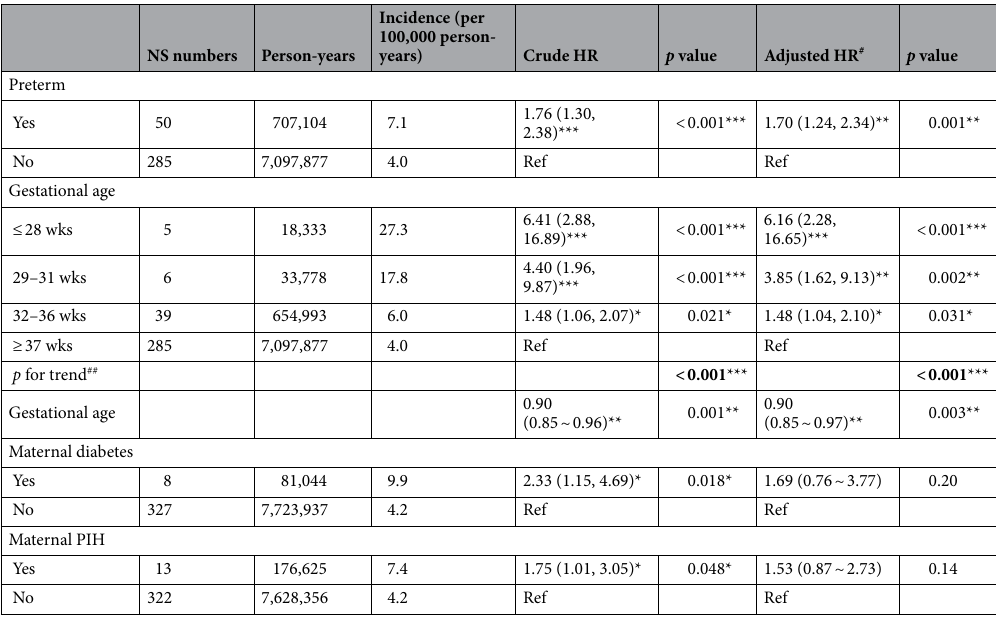
Table 2. Comparison of the incidence of subsequent nephrotic syndrome in the different gestational age groups. PIH was defined as hypertension that complicated pregnancy after 20 weeks of gestation. # Adjusted for SGA, urbanization, family income, paternal age, maternal age and maternal complications. ## p for trend was to test the effect of varying gestational age on the incidence of nephrotic syndrome. *p < 0.05, ** p < 0.01, *** p <